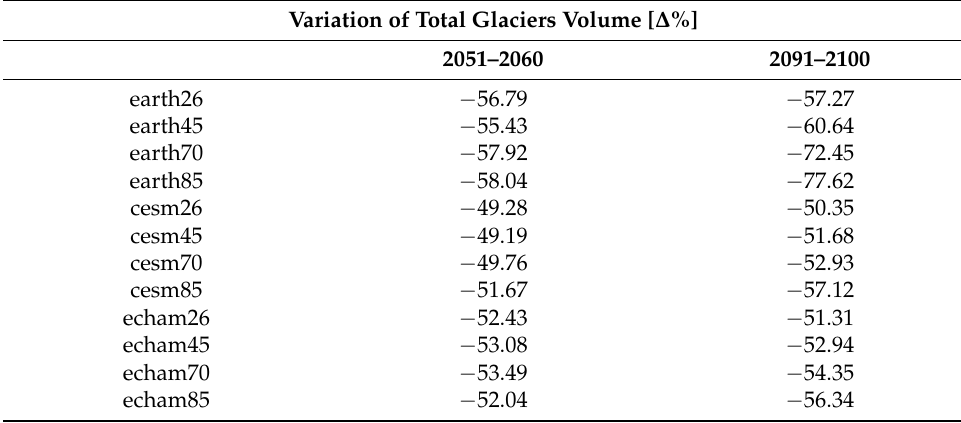
Figure 10. Projected ice volume until 2100 for each SSP, averaged for different GCMs. Table 3. Percentage variation of ice volume with respect to the CR period.